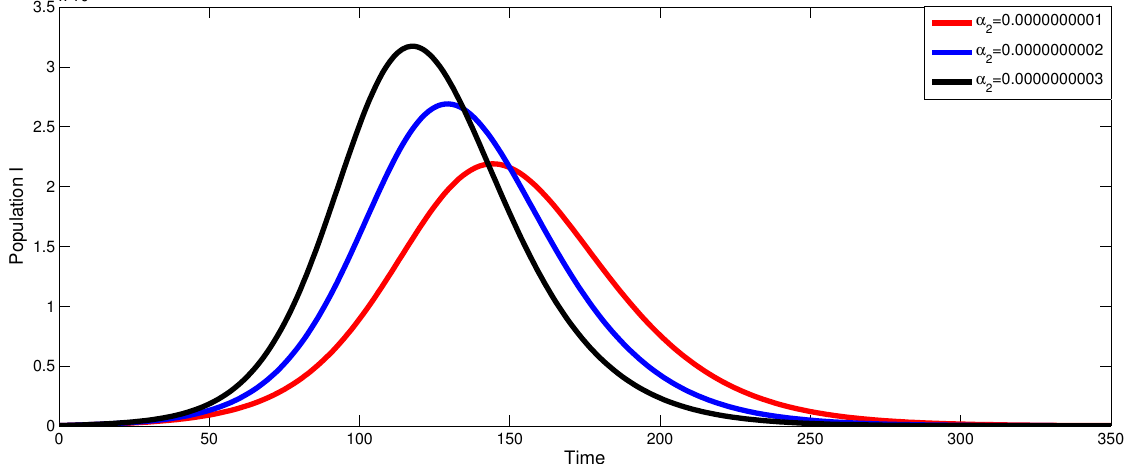
Fig. 5. Time series of infected population with parameter values and initial conditions from Table 1 and 2 during 1 / 4 / 2020 to 29 / 5 / 2020 .